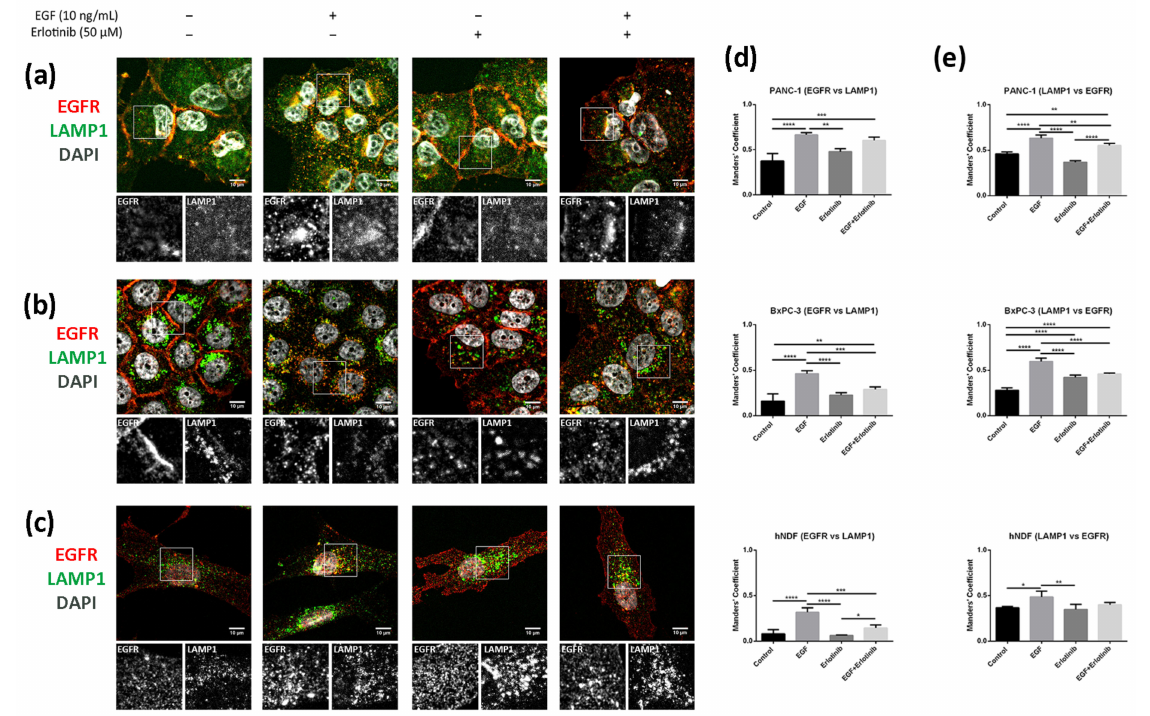
Figure 10. Colocalization analysis of the EGFR and LAMP1 (lysosomes) in cells incubated with EGF, erlotinib or both in 2D cultures. EGFR (red) and LAMP1 (green) immunofluorescence counterstained with DAPI (grey) in ( a ) PANC-1; ( b ) BxPC-3 and ( c ) hNDF cells. Scale bars represent 10 µ m. Gray pictures show close-up sections of each marker; ( d ) Manders’ colocalization coefficients showing the proportion of EGFR overlapping with LAMP1; ( e ) Manders’ colocalization coefficients showing the proportion of LAMP1 overlapping with EGFR. Statistical differences are indicated as * for p < 0.05, ** for p < 0.01, *** for p < 0.001 and **** for p <